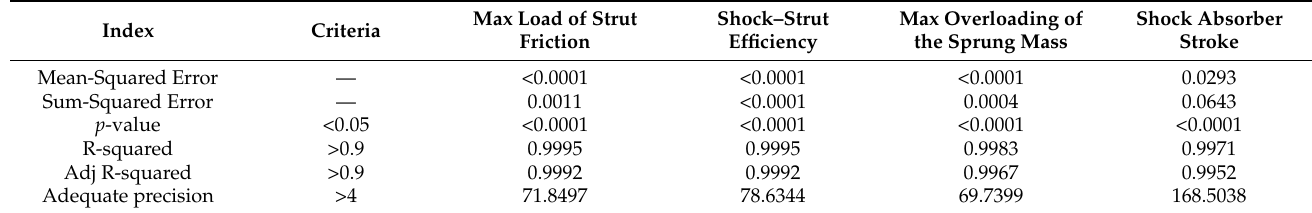
Table 8. The ANOVA results of RS model for the four response values.